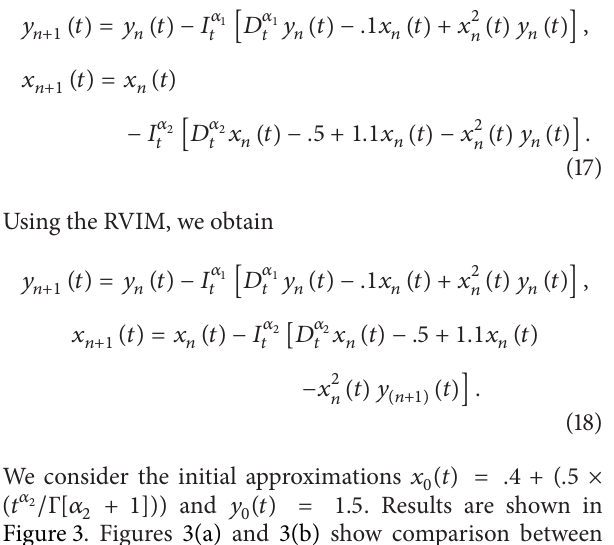
Figure 3. Figures 3(a) and 3(b) show comparison between the approximate solutions (𝑥(𝑡) ≅ 𝑥 2 (𝑡)) , (𝑦(𝑡) ≅ 𝑦 3 (𝑡)) of (15) obtained using VIM and RVIM for the special